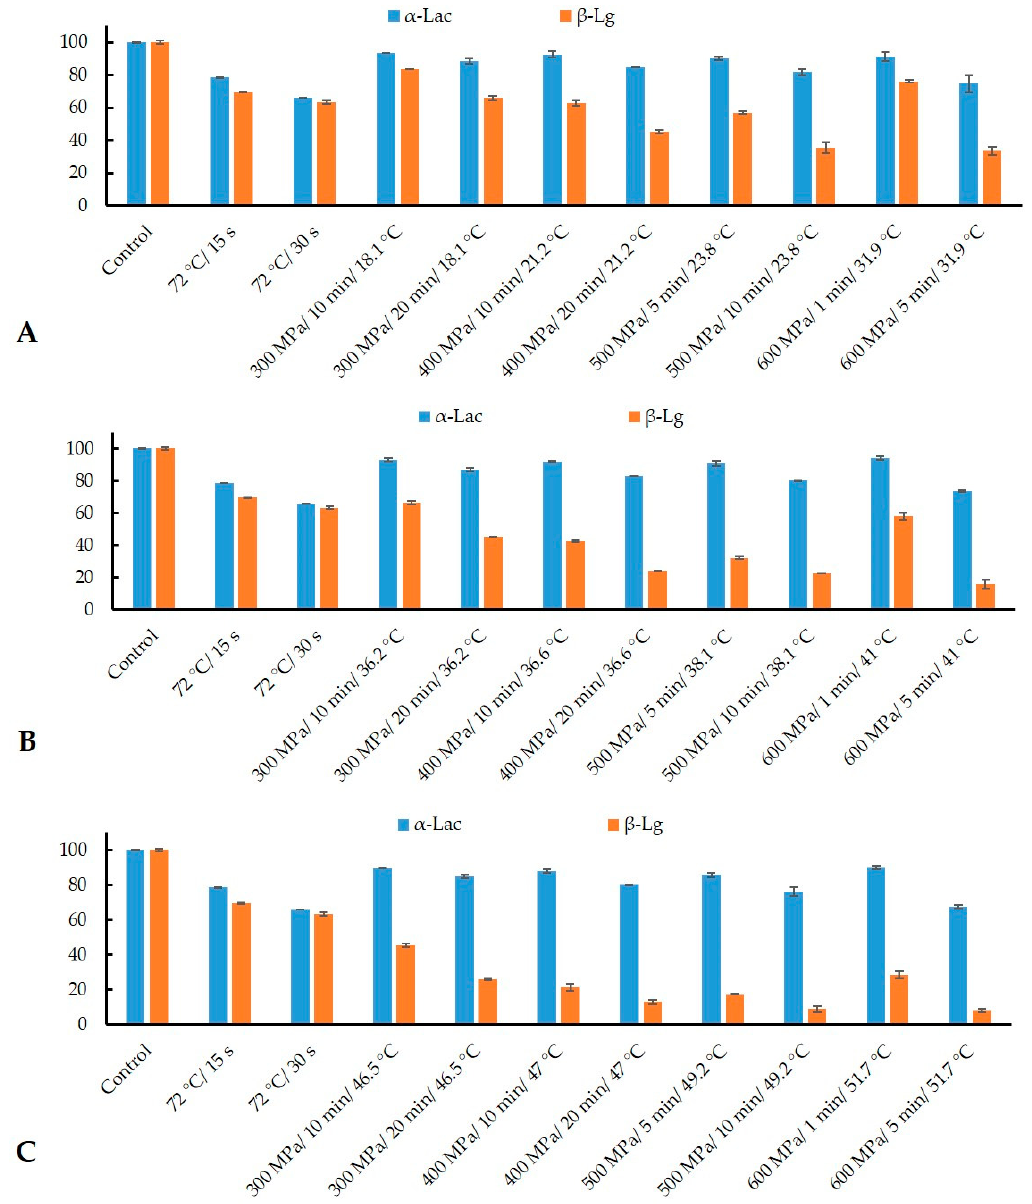
Figure 6. Retention of α -Lac and β -Lg (%) after high-temperate short-time (HTST) pasteurization at 72 °C for 15 and 30 s, and HPP applied at ~20 °C ( A ), ~30 °C ( B ), and ~40 °C( C ). Error bars represent the standard deviations of duplicates.